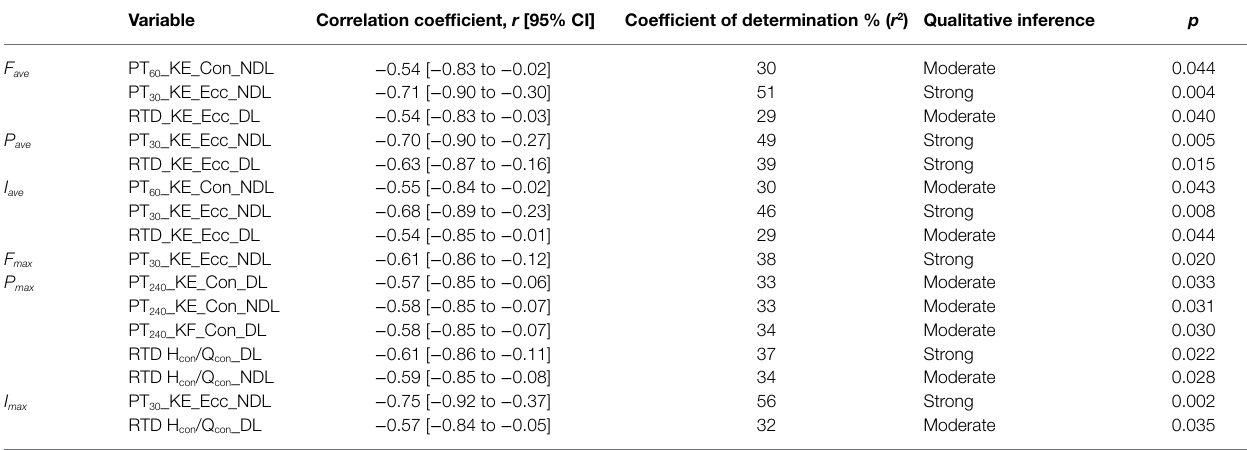
TABLE 5 | Pearson’s significant correlation results between the deceleration ability variable and lower limb peak torque, RTD H/Q ratio in DL and NDL. Variable Correlation coefficient, r [95% CI] Coefficient of determination % ( r 2 ) Qualitative